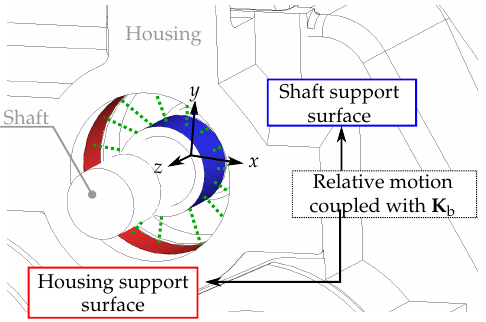
Figure 12. Bearing approximation by K b to couple the relative motion of the interfaces on shaft (red) and housing (red), lumped with RBE